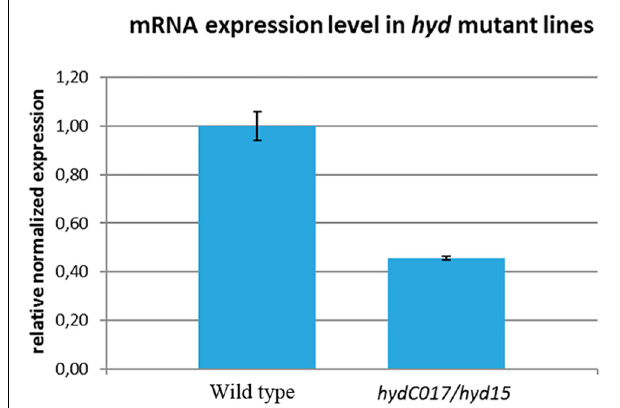
FIGURE 1 | Comparison of hyd mRNA expression levels between wild-type and hydC017/hyd15 ovaries as estimated by real-time PCR. The hyd expression is ∼ 2-fold lower in the mutants than in the wild-type ovaries. The mean values ± standard deviation of the transcript abundance of three separate